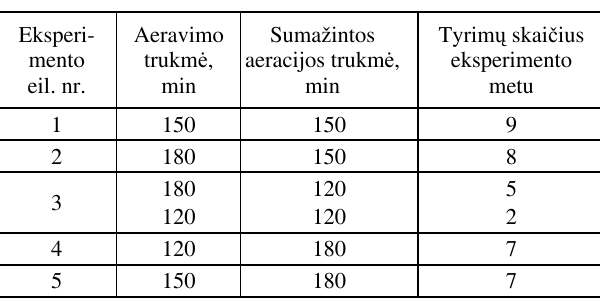
Table 1. Duration of nitrification and denitrification during